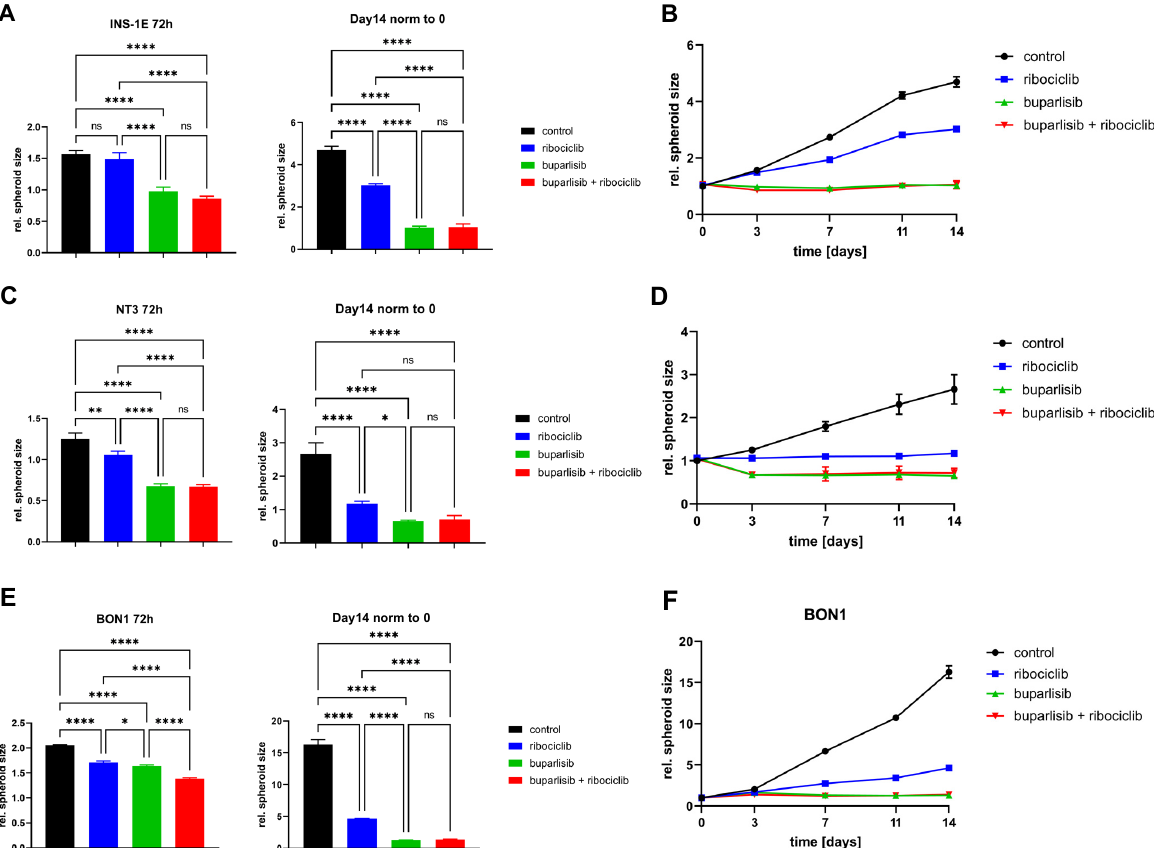
Figure 6. Effect of buparlisib and ribociclib on growth of INS-1E, NT-3 and BON-1 PanNET cells in 3D culture. ( A , C , E ) Changes in spheroid size at 72 h (3d) and 14d after treatment with buparlisib, ribociclib or their combination in INS-1E ( A ), NT-3 ( C ) and BON-1 ( E ) cells. ( B , D , F ) Effect of the treatments on the relative spheroid size (versus day 0) over the course of 14 days in INS-1E ( B ), NT-3 ( D ) and BON-1 ( F ) cells. Data shows the mean ± SD from three independent experiments with eight technical replicates each. ns, not significant; *, p < 0.05; **, p < 0.01; ****, p < 0.0001 (by 1way